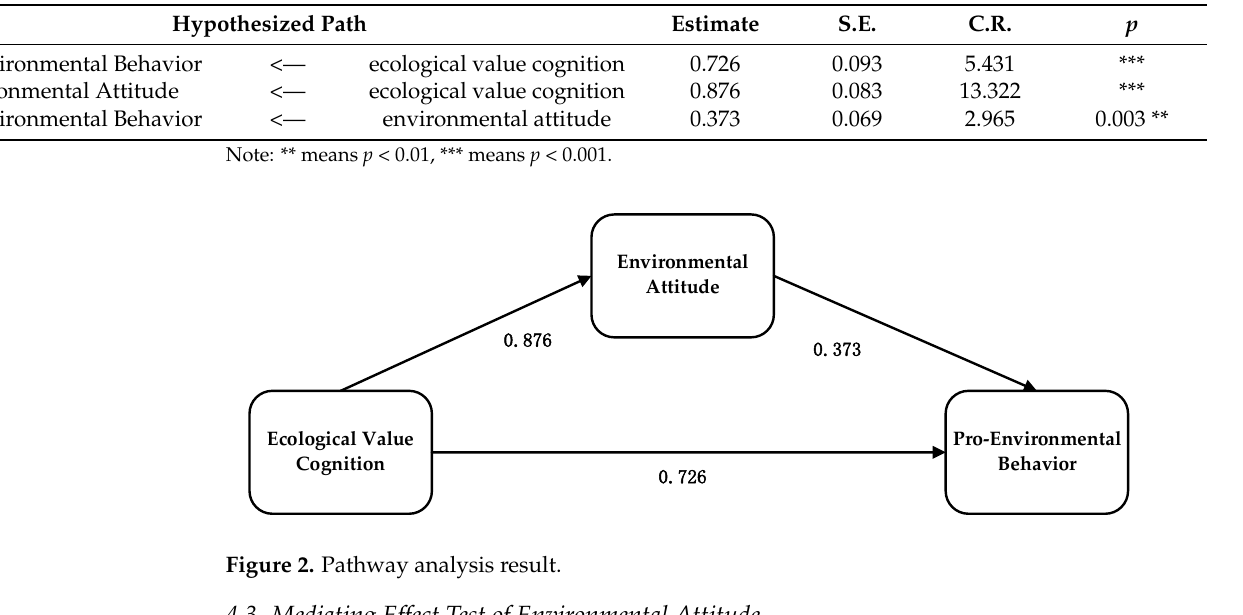
Table 11. Bootstrap for mediating effect test. Mediating Hypothesis Path